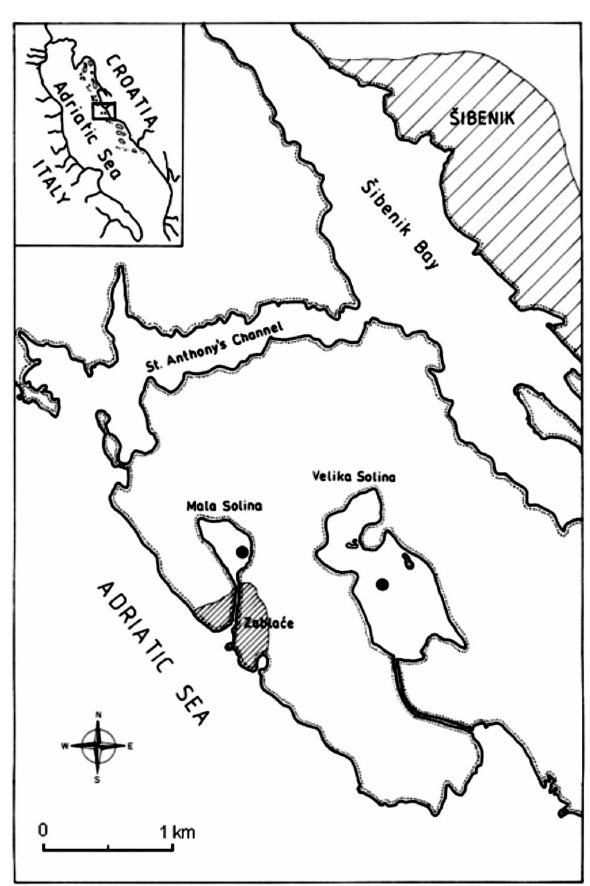
Fig . 1. – Geographic location of Mala Solina and Velika Solina with sampling